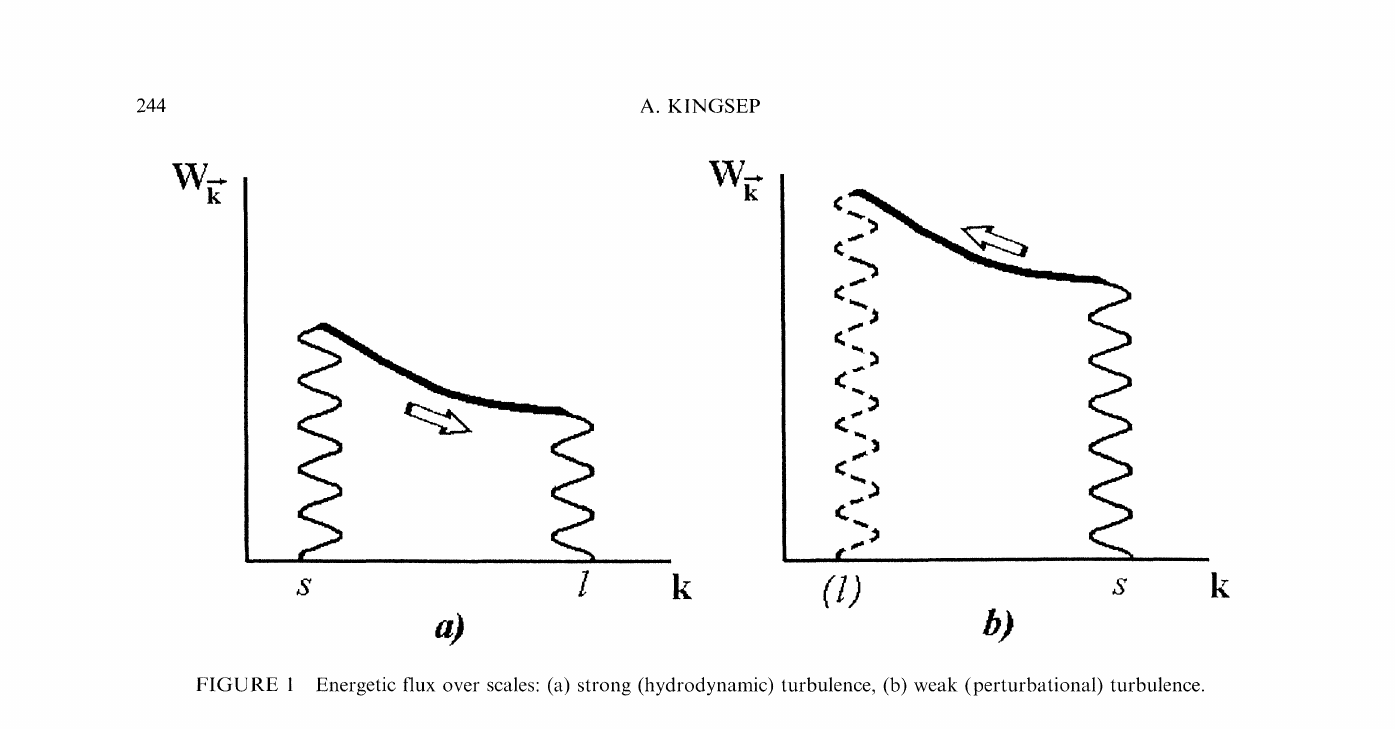
k S FIGURE Energetic flux over scales: (a) strong (hydrodynamic) turbulence, (b) weak (perturbational) turbulence.